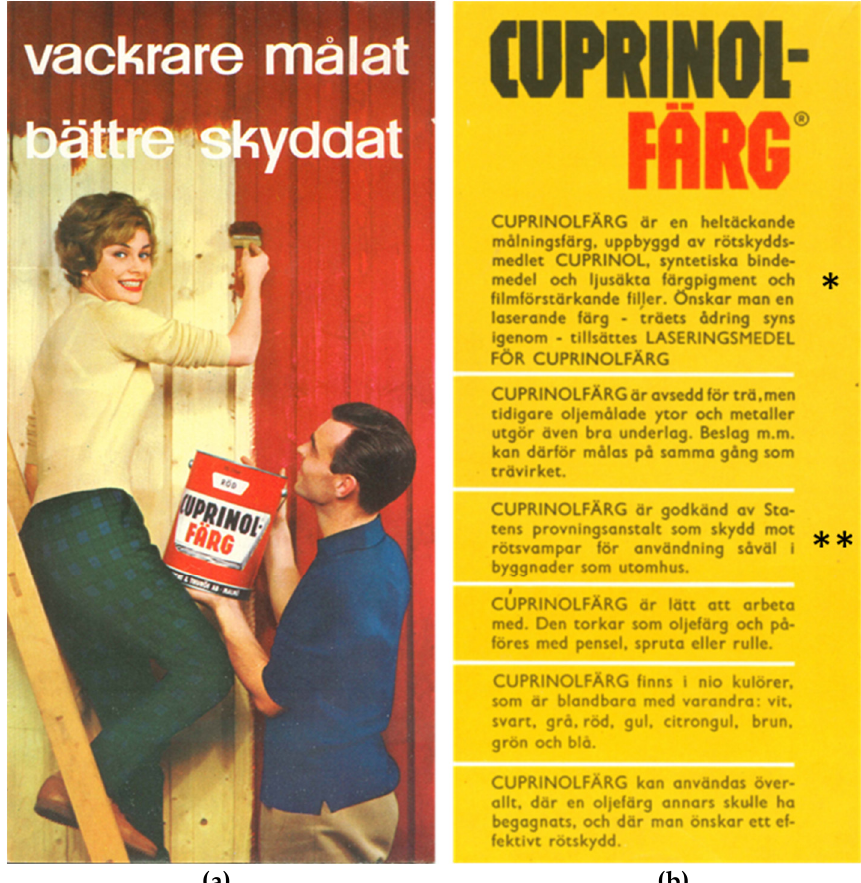
Figure 4. ( a ) Front page of an advertisement pamphlet “More beautifully painted,